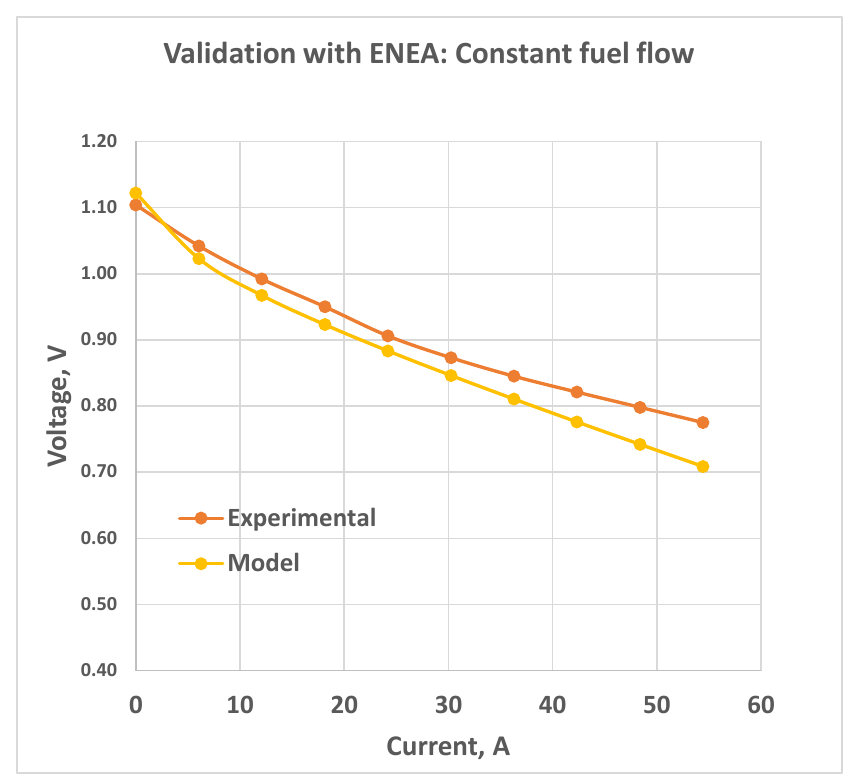
Figure 10. Validation results for the constant fuel flow operation; mean absolute relative error =